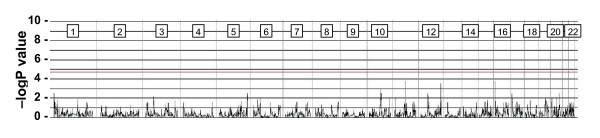
Linkage test results for CEPH control population. Genome-wide IBD sharing with standardized ratios was determined as described in Methods. Based on sib pairs from 54 independent families, no clones in chromosomes 1 through 22 surpass the threshold of significance at 2 × 10-5 (red line).